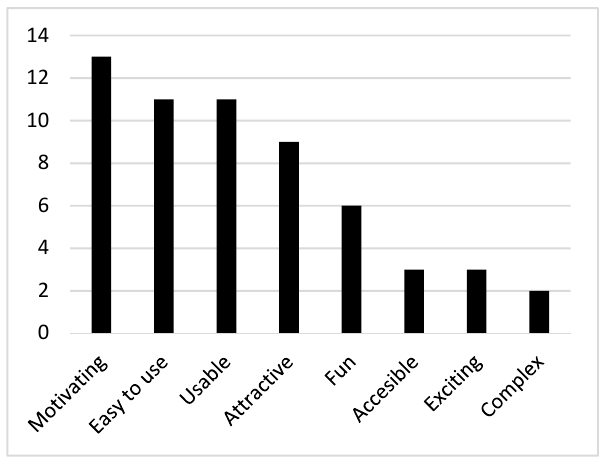
Figure 4. Words most frequently used by users to describe the NetAR application.